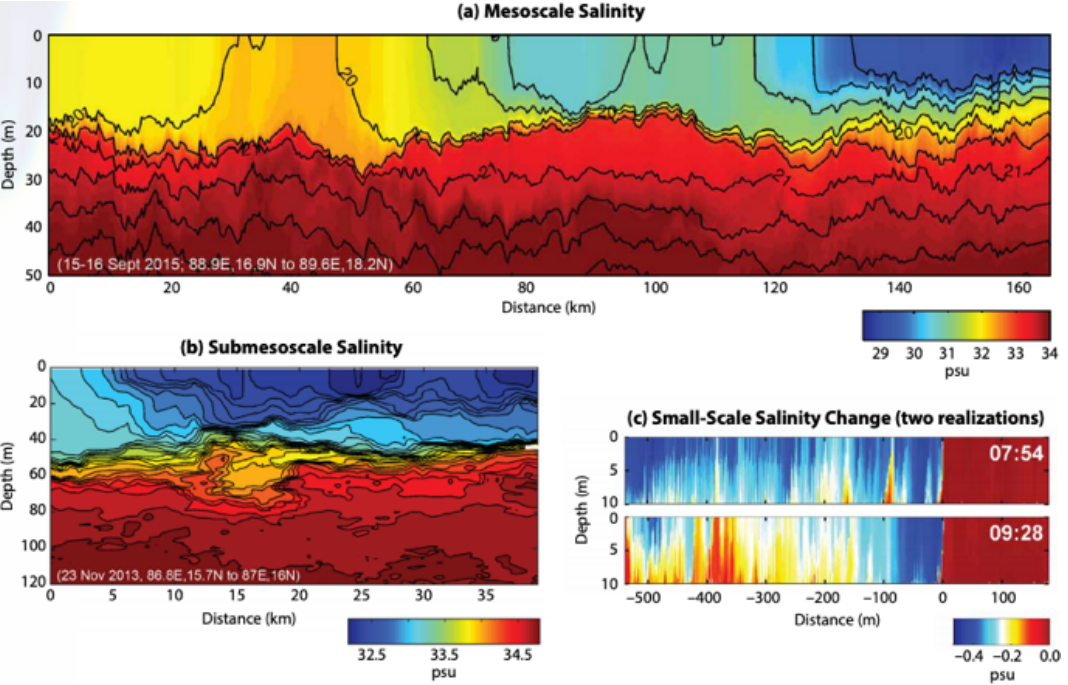
Figure 21. Observed salinity gradients at mesoscale, sub-mesoscale, and small horizontal scales in the Bay of Bengal (Nash et al., 2016).